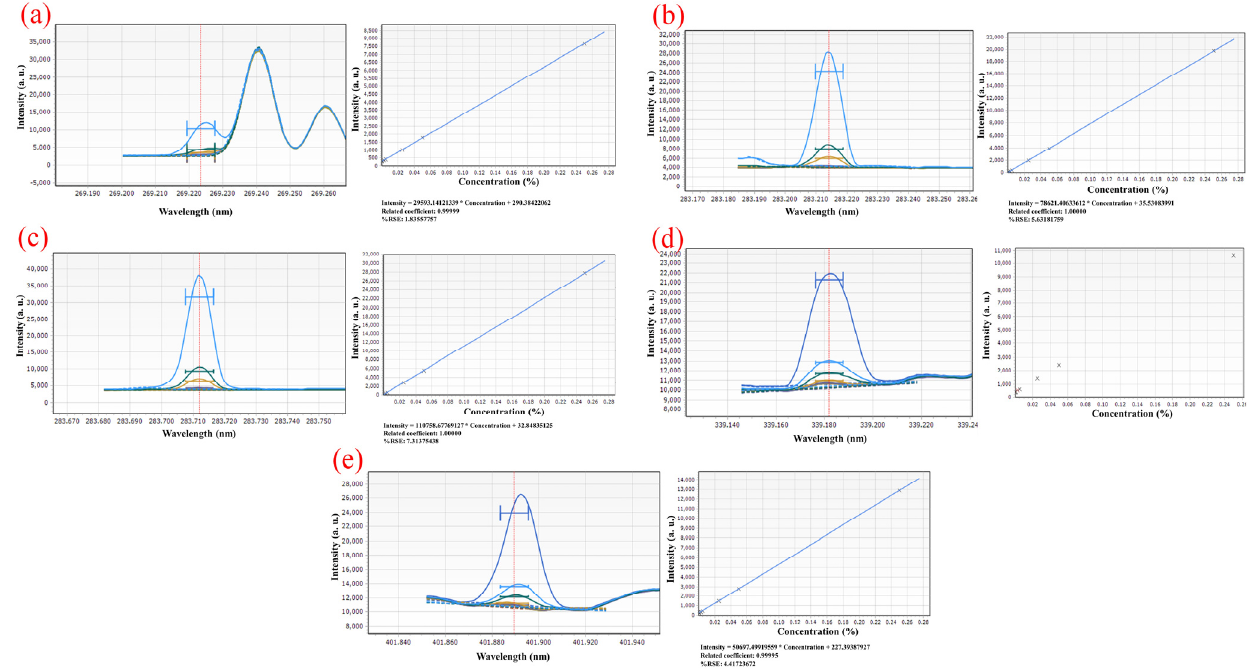
Figure 3. Element spectrum of Th in ( a ) 269.242 nm; ( b ) 283.232 nm; ( c ) 283.730 nm; ( d ) 339.203 nm; ( e ) 401.913 nm.